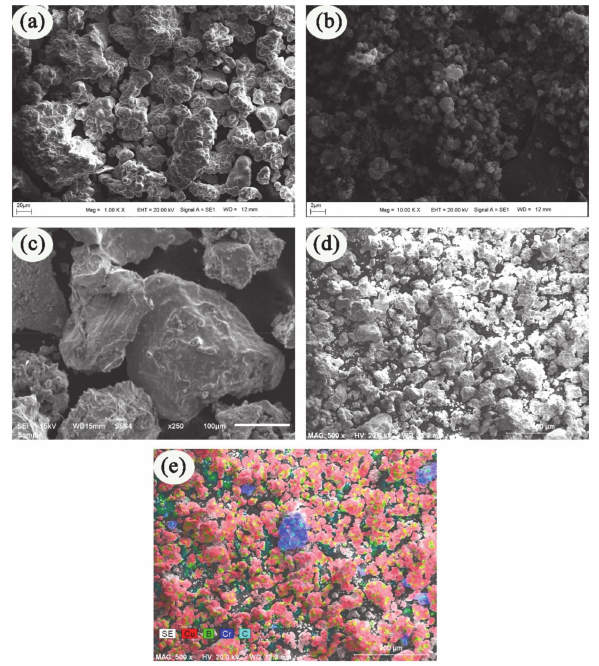
Figure 1. SEM images of powders used in composite material production ( a ) Cu [26] ( b ) B ( c ) CrC ( d ) mixed powder (5 wt.%), and ( e ) EDX mapping analysis of Figure 1d.